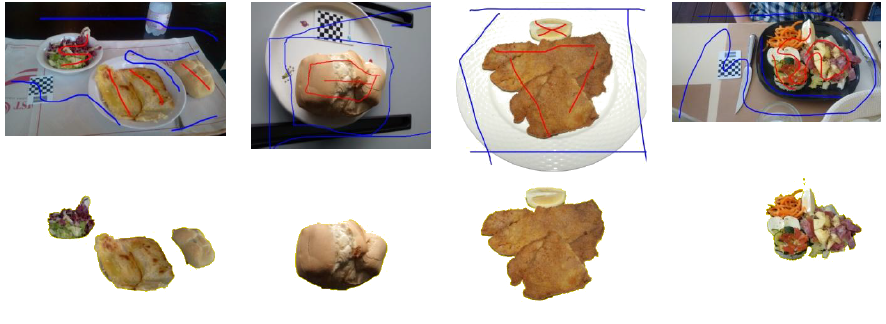
Figure 3. Results of the semi-automatic image segmentation method. Images need to be marked by the user, as shown, before being